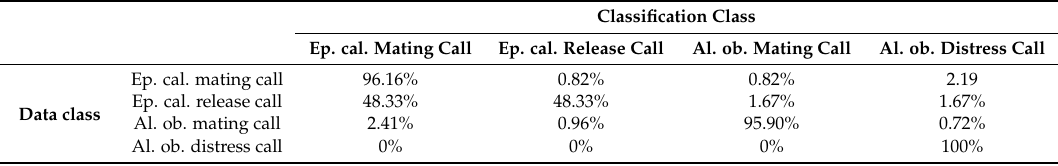
Table 9. Confusion matrix using MFCCs (optimal values in every option) and the Bayes Classifier.